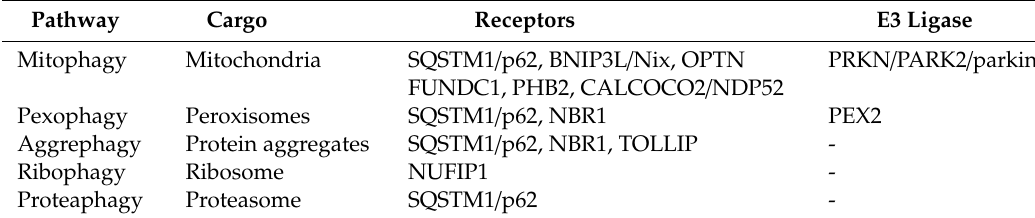
Table 2. Cargo, receptor and E3 ligase of selective autophagy in